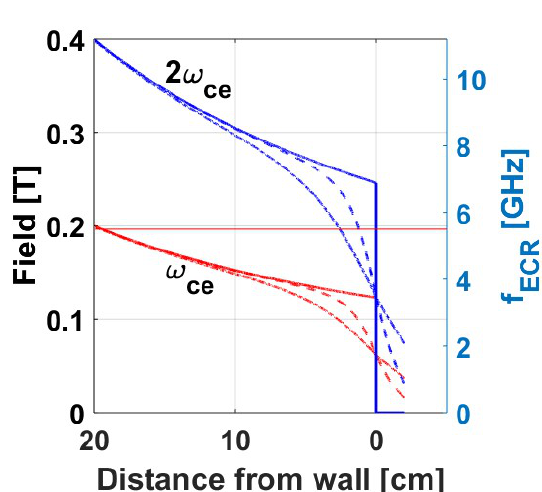
Fig 4. Edge magnetic field reduction on porthole axis due to porthole field error for a 320kA discharge. Magnetic fields are plotted in absence of a porthole (solid line), for 5cm (-- line) and 12cm (-. line) portholes corresponding to first harmonic (red) and second harmonic (blue) resonances (excluding Doppler shift). Launch frequency at 5.5GHz is marked with a horizontal red line.